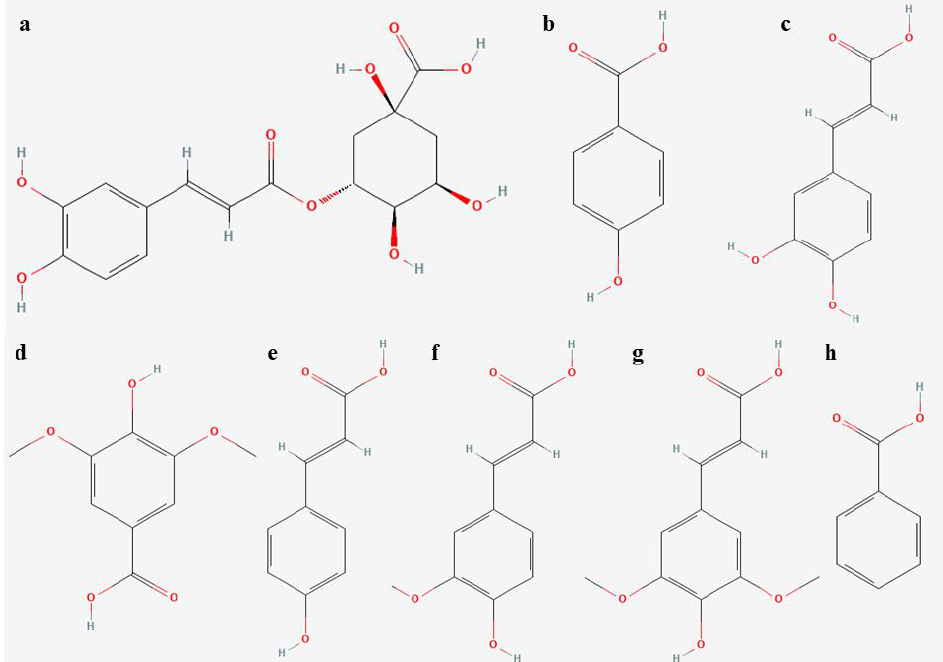
Figure 3. Chemical structure of phenolic acids isolated in extracts of L. aestivum in vitro plants ( a ) chlorogenic acid, ( b ) p -hydroxybenzoic acid, ( c ) caffeic acid, ( d ) syringic acid, ( e ) p -coumaric acid, ( f ) ferulic acid, ( g ) sinapic acid, ( h ) benzoic acid.